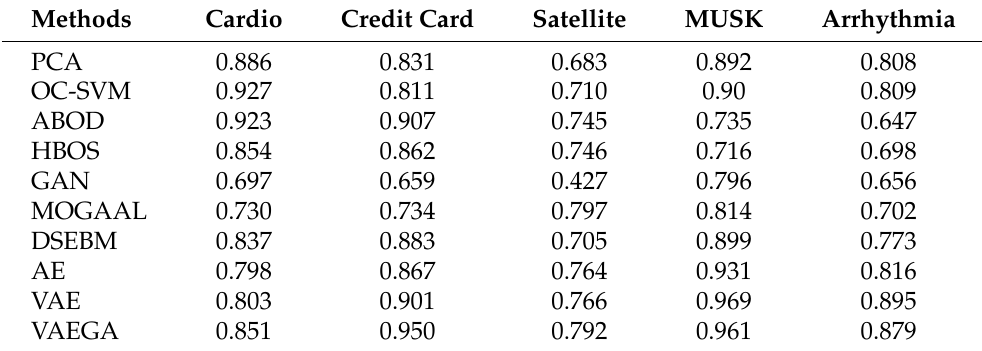
Table 2. Accuracy results of outlier detection for 10 models on 5 datasets.